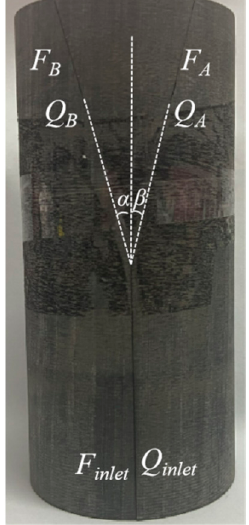
Figure 1. Preparation of bifurcated fractures.